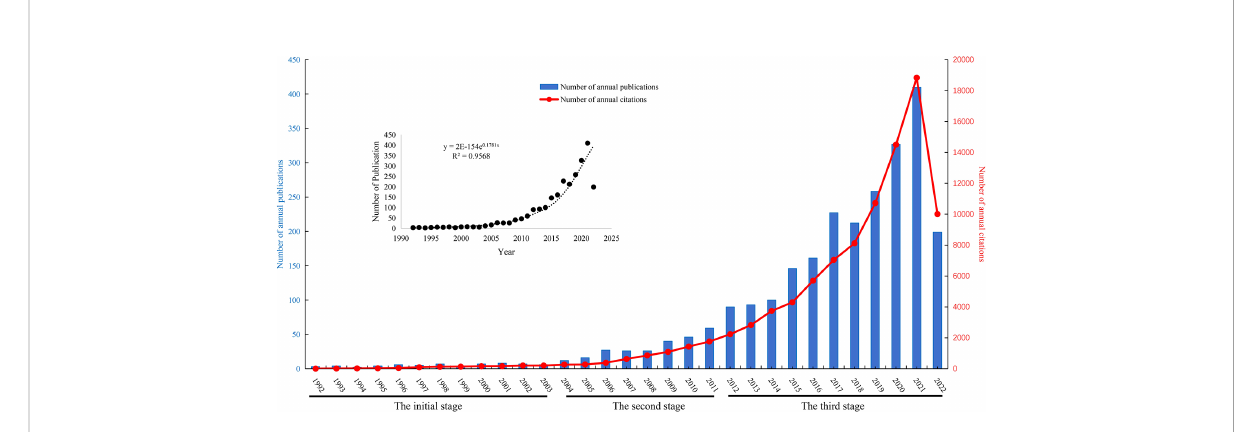
FIGURE 2 Distribution of the annual published documents and citations research related to metabolic signaling pathways of tumor drug resistance from 1992 to